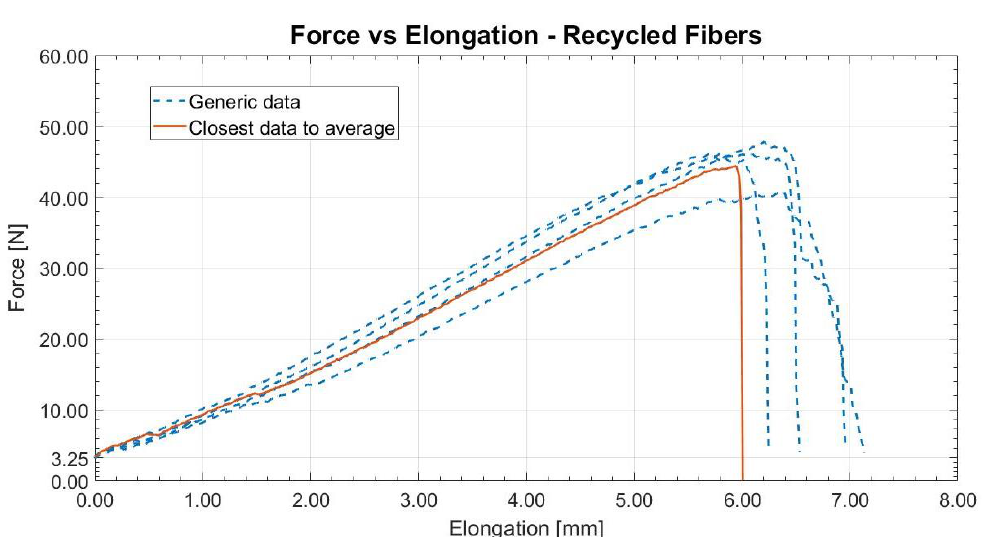
Figure 8. Force vs. Elongation curve of recycled basalt